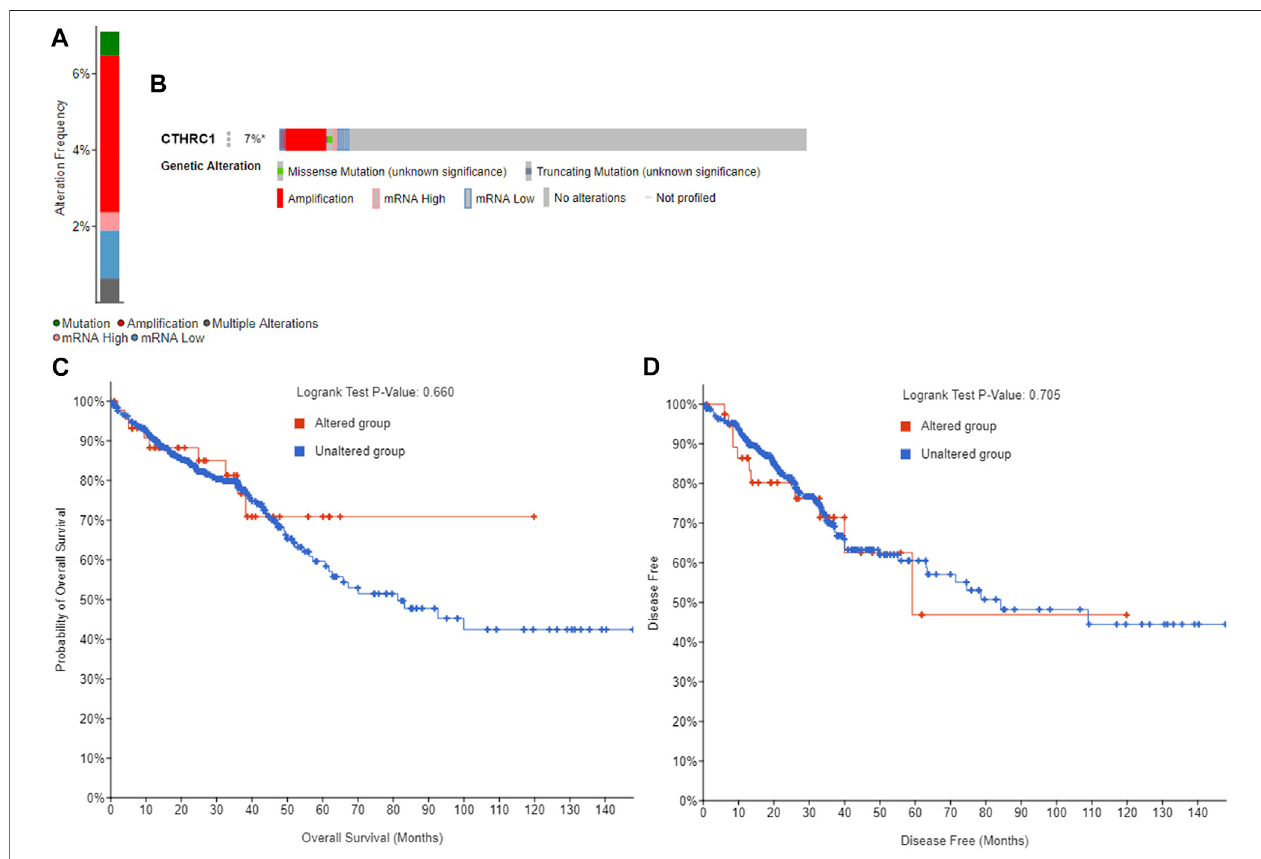
FIGURE 5 | Alteration frequency analysis of CTHRC1 and its in fl uence on prognosis in patients with colorectal cancer using cBioPortal. (A) Alteration frequency of CTHRC1 in patients with colorectal cancer. (B) Effect of CTHRC1 alteration on the overall survival of COAD patients. (C) Effect of CTHRC1 alteration on the disease free survival of COAD patients. (D) Effect of CTHRC1 alteration on the disease free survival of COAD